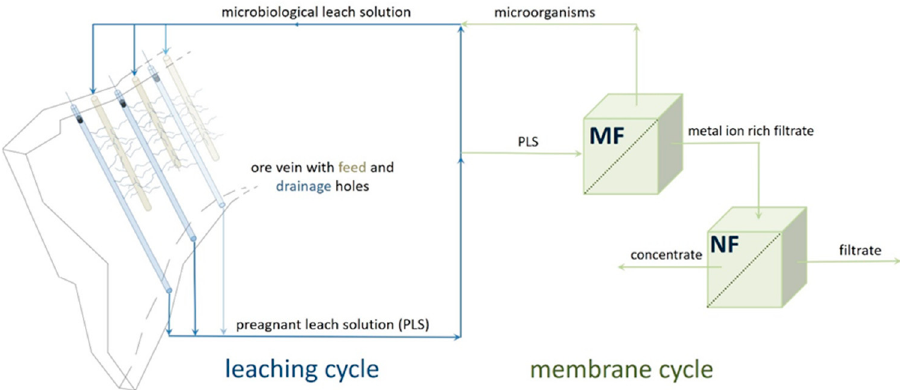
Figure 1. Schematic process flow of leaching and downstream processing (MF: microfiltration; NF: nanofiltration) at research mine Reiche Zeche Freiberg, Germany.